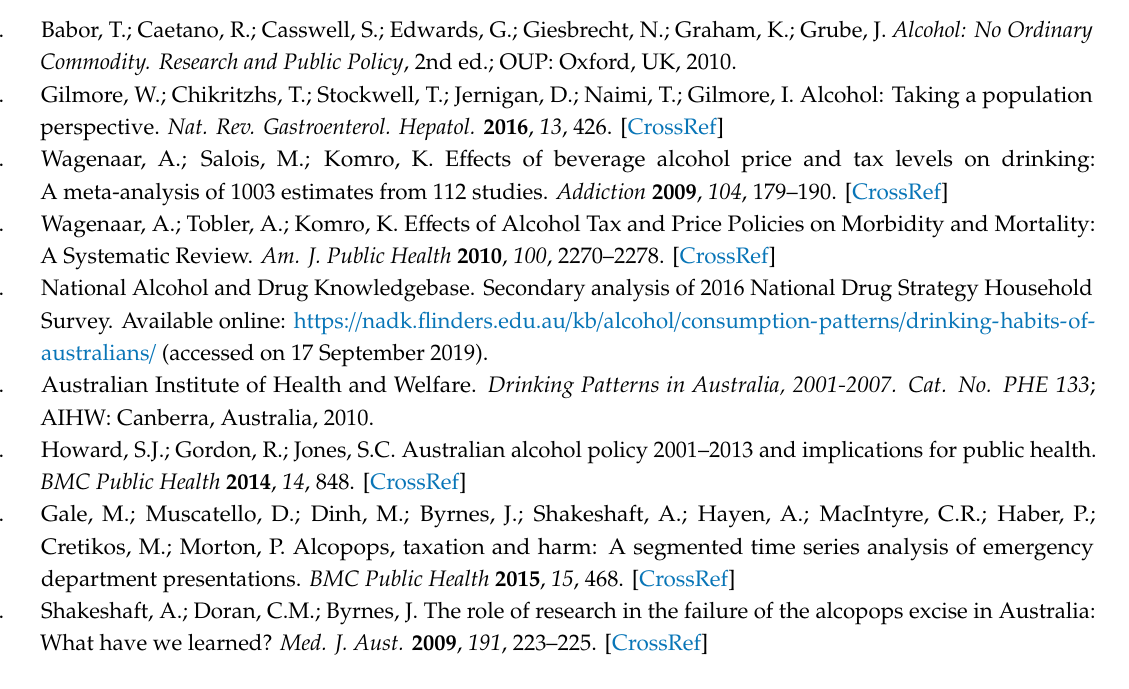
Figure S1: Monthly chlamydia notification counts by gender and age group, July 2000 to December 2016. Alcopops tax intervention point indicated by dotted line at May 2008, Figure S2: Monthly estimated resident population by gender and age group, July 2000 to December 2016. Alcopops tax intervention point indicated by dotted line at May 2008. Quarterly estimated resident population was interpolated within age group and gender to achieve monthly data points, Figure S3: Monthly CPI-adjusted per capita total income ($) by age group and gender, July 2000 to Dec 2016. Alcopops tax intervention point indicated by dotted line at May 2008, Figure S4: Annual litres of pure alcohol consumed per capita by beverage type, 2002-03 to 2015-16. Alcopops tax intervention point indicated by dotted line at 2007-08, Table S1: ARIMA model results of the association between introduction of the alcopops tax and monthly chlamydia test positivity rates (secondary outcome) by age group and gender with a two-month realignment of test to notification month, July 2000 to December 2016, Table S2. ARIMA model results of the association between introduction of the alcopops tax and monthly chlamydia test counts by age group and gender, July 2000 to December